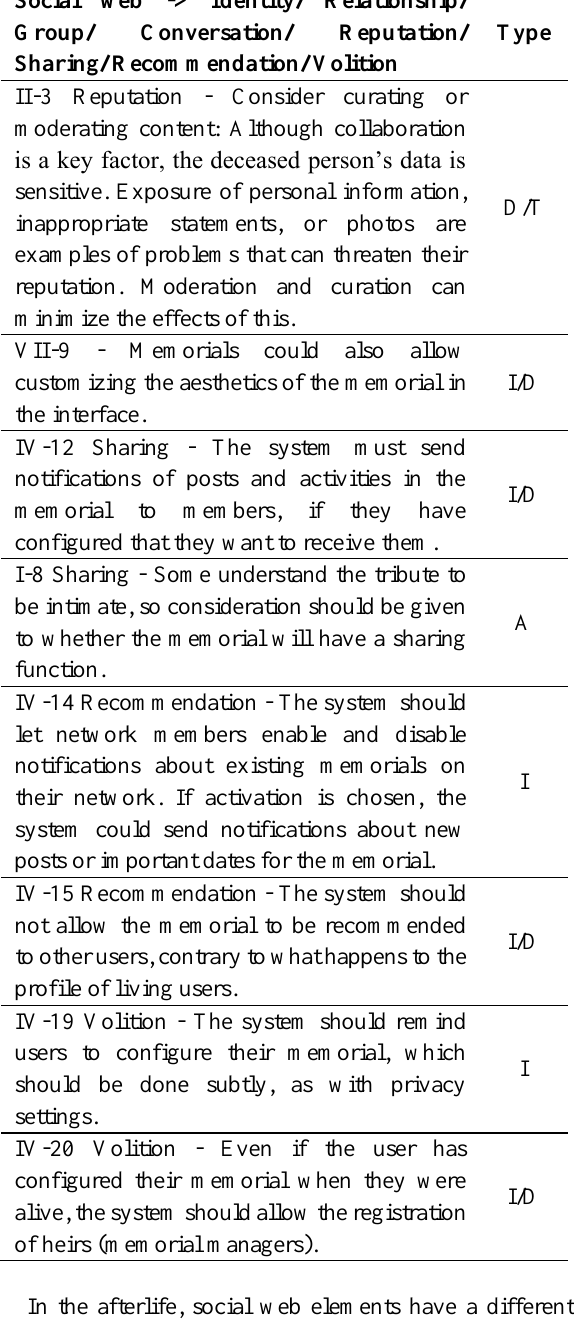
Table 5. Social web